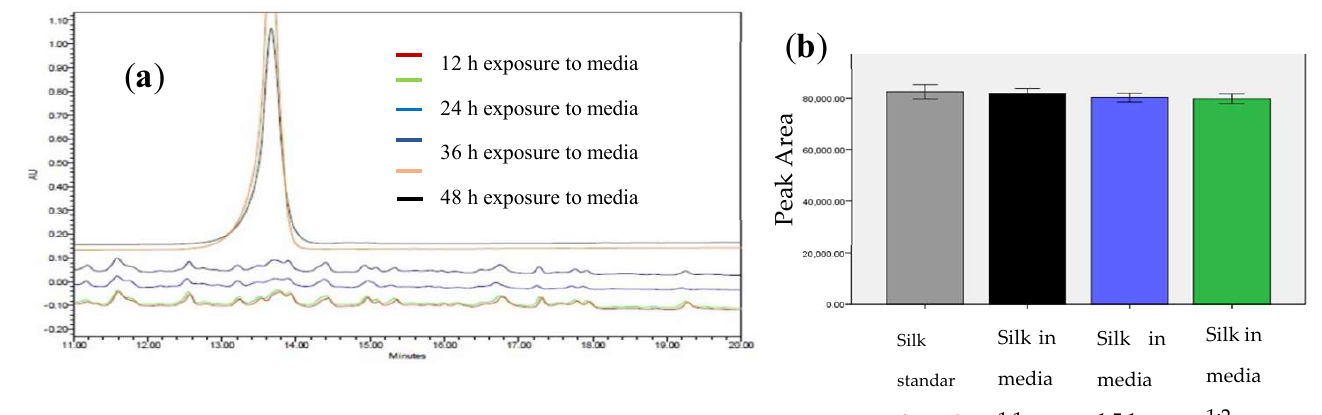
Figure 3. ( a ) HPLC chromatogram of TSP exposed to the bacterial media from S. aureus culture shows the disappearance of the peak at 13.5 min within 12 h of exposure to the media (bottom brown graph), while the peak was not only still evident after 48 h (black graph), but it was also relatively unchanged. ( b ) The area under the curve of the chromatogram of silk peptide exposed to the bacterial media, showing the stability of the peptide even after 48 h.